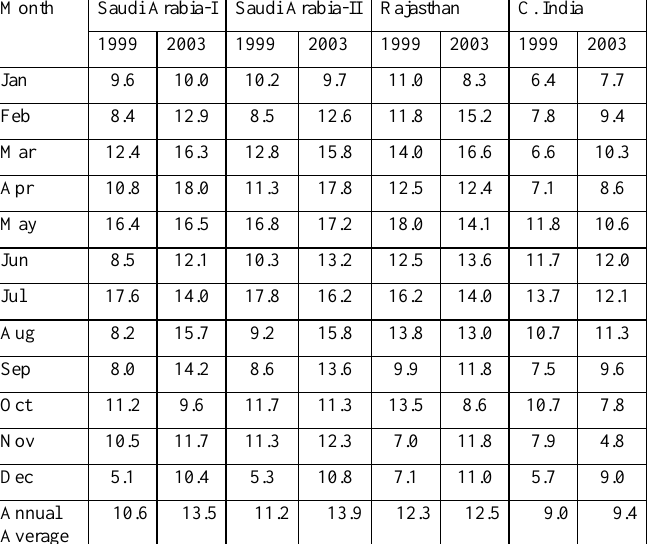
Table 4. Comparison of Daily Maximum IDDI (K). Table-4. Comparison of Daily Maximum IDDI